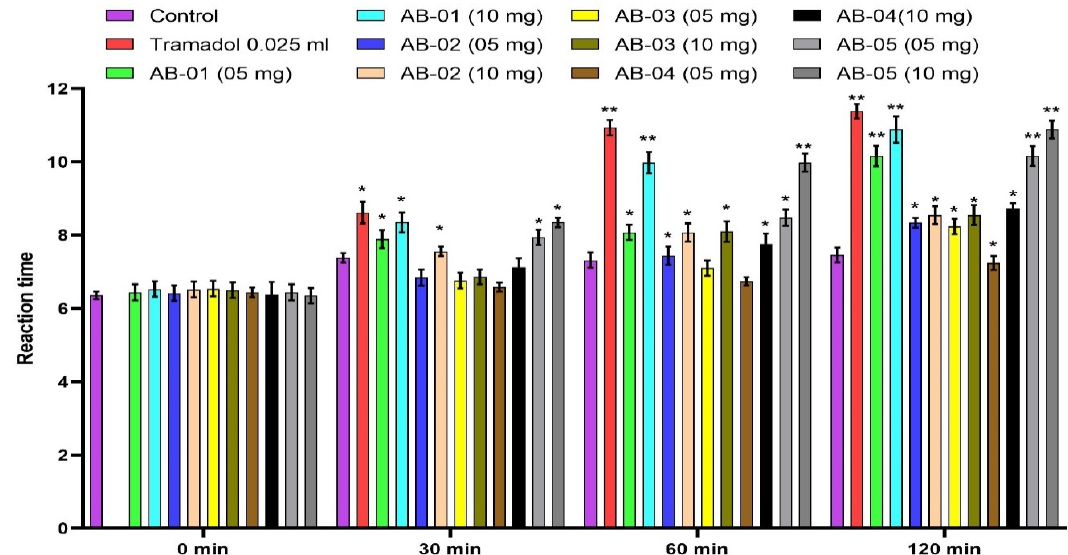
Figure 2. Effect of isolated compounds AB-01, AB-02, AB-03, AB-04, AB-05 and Tramadol (Standard) on the reaction time of mice exposed to the hot plate. Each value is expressed in Mean ± S.E.M. One-way ANOVA followed by Dunnett’s test, p : * p < 0.05 and ** p < 0.01, compared with respective control group.